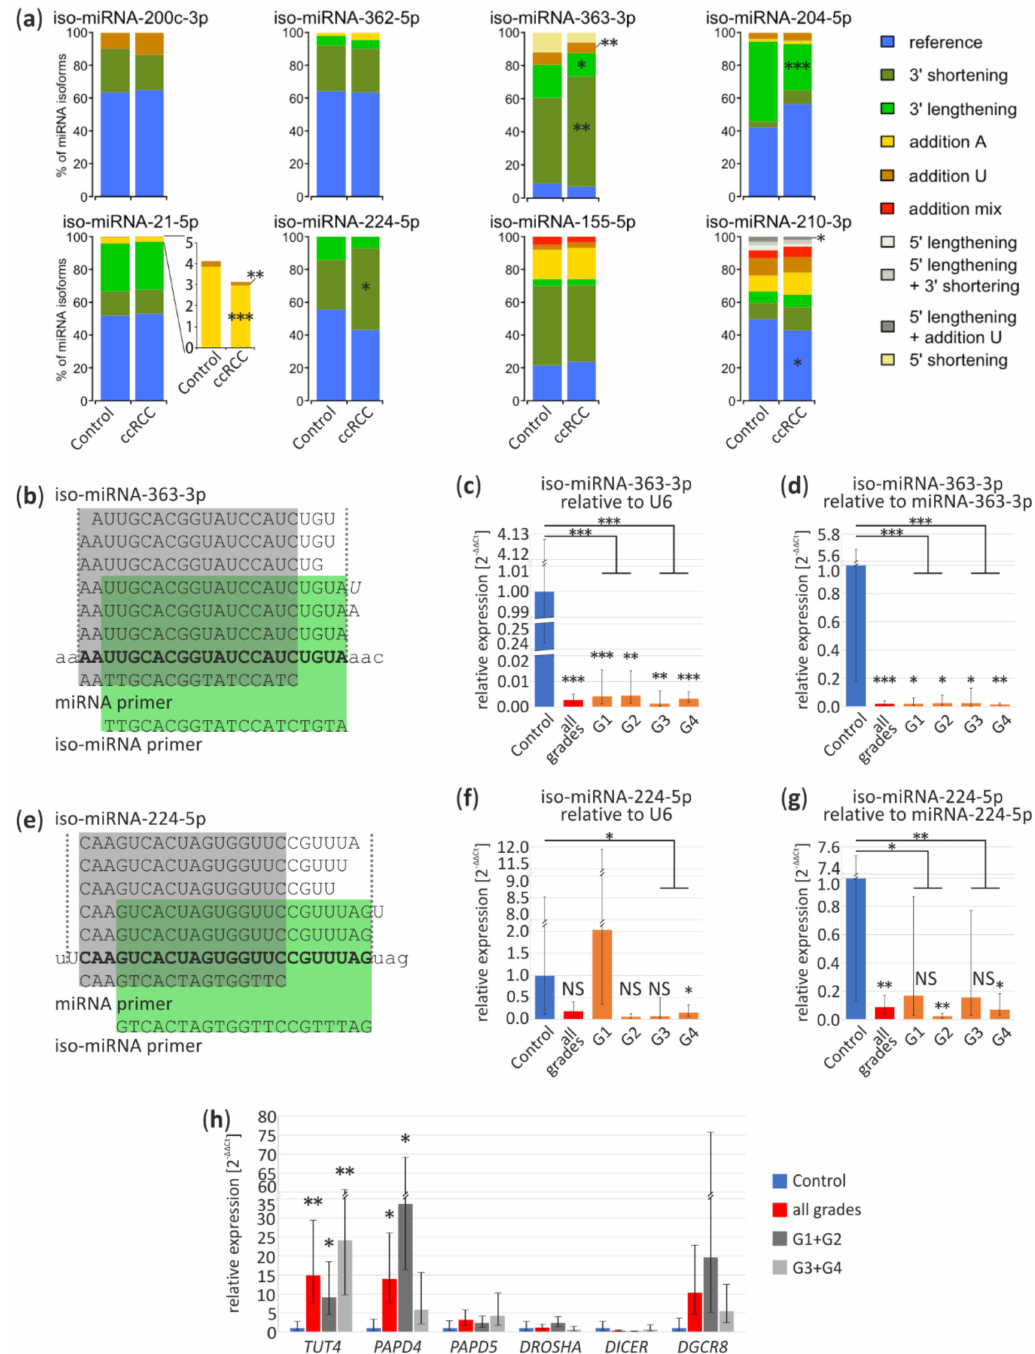
Figure 4. miRNA isoform deregulation in ccRCC tumors. ( a ) The percentage per miRNA isoform (iso-miRNA) in control and tumor samples based on Exp1 results. Part of the chart represents the percentage of iso-miRNA-21-5p is magnified to show more accurately 3 (cid:48) tailing of miRNA-21-5p; ( b , e ) Sequences of miRNA-363-3p and miRNA-224-5p isoforms identified in kidney, respectively. “miRNA primer” (in grey) amplifies all iso-miRNA and “iso-miRNA primer” (in green) amplifies reference miRNA and longer iso-miRNA. Bold, reference miRNA sequence; small letters, pre-miRNA sequence; italic, additional U or A nucleotides; ( c , d ) Validation of iso-miRNA-363-3p in ccRCC tumors and controls by qPCR relative to U6 ( c ) and miRNA-363-3p ( d ); ( f , g ) Validation of iso-miRNA-224-5p in ccRCC tumors and controls by qPCR relative to U6 ( f ) and miRNA-224-5p ( g ); ( h ) qPCR analysis of expression of genes involved in miRNA processing and after maturation modifications in ccRCC tumors. Control ( n = 4), ccRCC ( n = 17) containing: G1 ( n = 4), G2 ( n = 3), G3 ( n = 5), G4 ( n = 5). NS, non-significant; * p < 0.05; ** p < 0.01 and *** p <